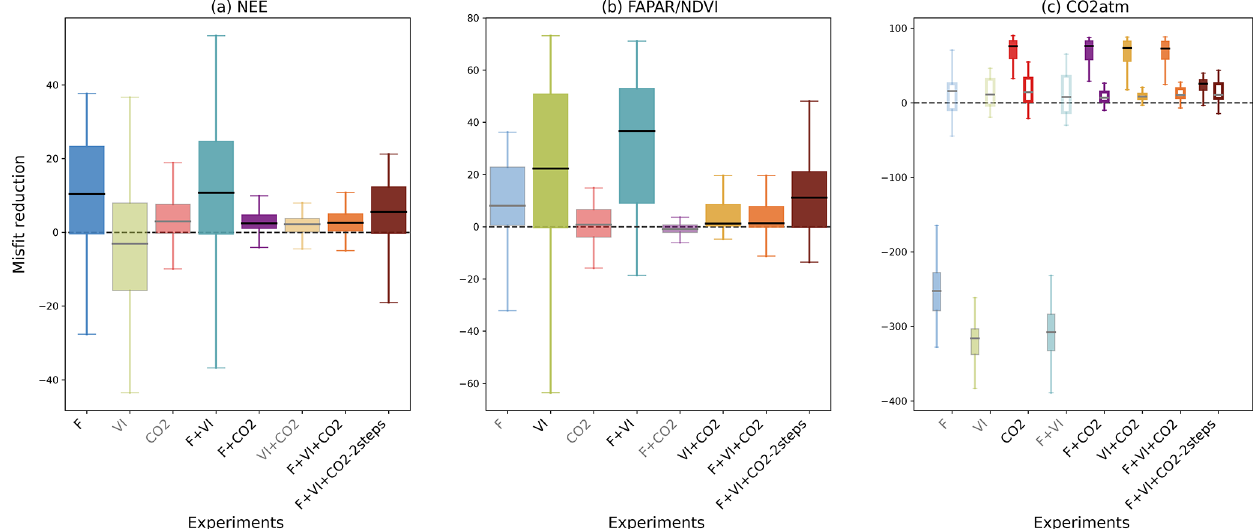
Figure 2. For all data streams, boxplots of the reduction of the model–data mismatch following the different assimilation experiments. For a given data stream, the assimilation experiments in which it is involved are labeled in black ( x axis) and the boxplot colors are dark-colored and in gray/light colors otherwise (back-compatibility check). For the atmospheric CO 2 concentration data at stations, the misfit reduction is calculated both for the raw (not detrended) data (left solid boxplot of each assimilation experiment, with colored boxplots) and the detrended data (right white boxplot of each assimilation